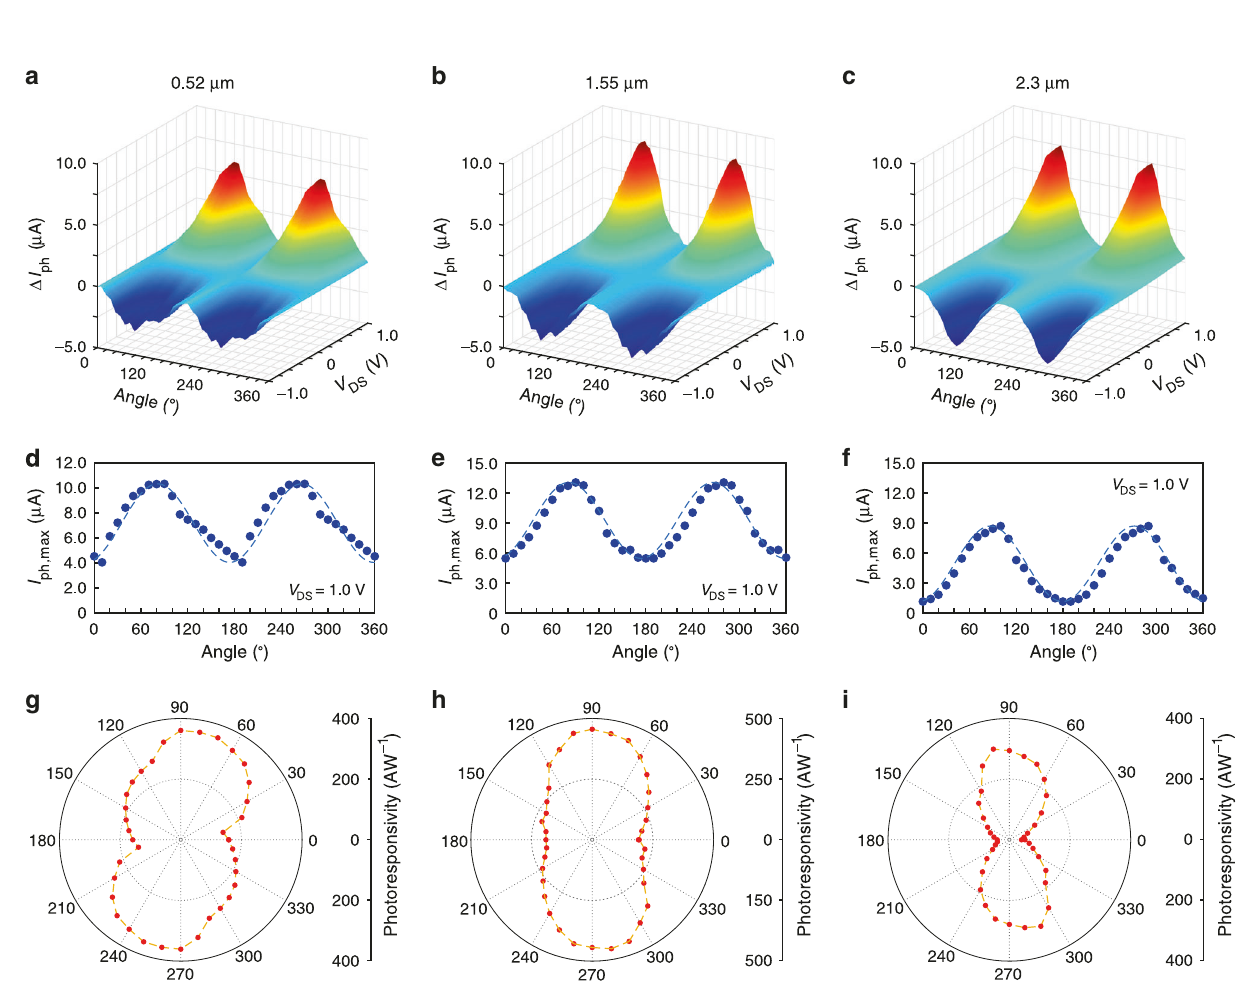
for the incident wavelengths of 0.52, 1.55, and p